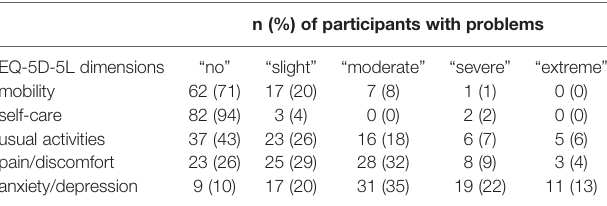
TABLE 4 | EQ-5D-5L